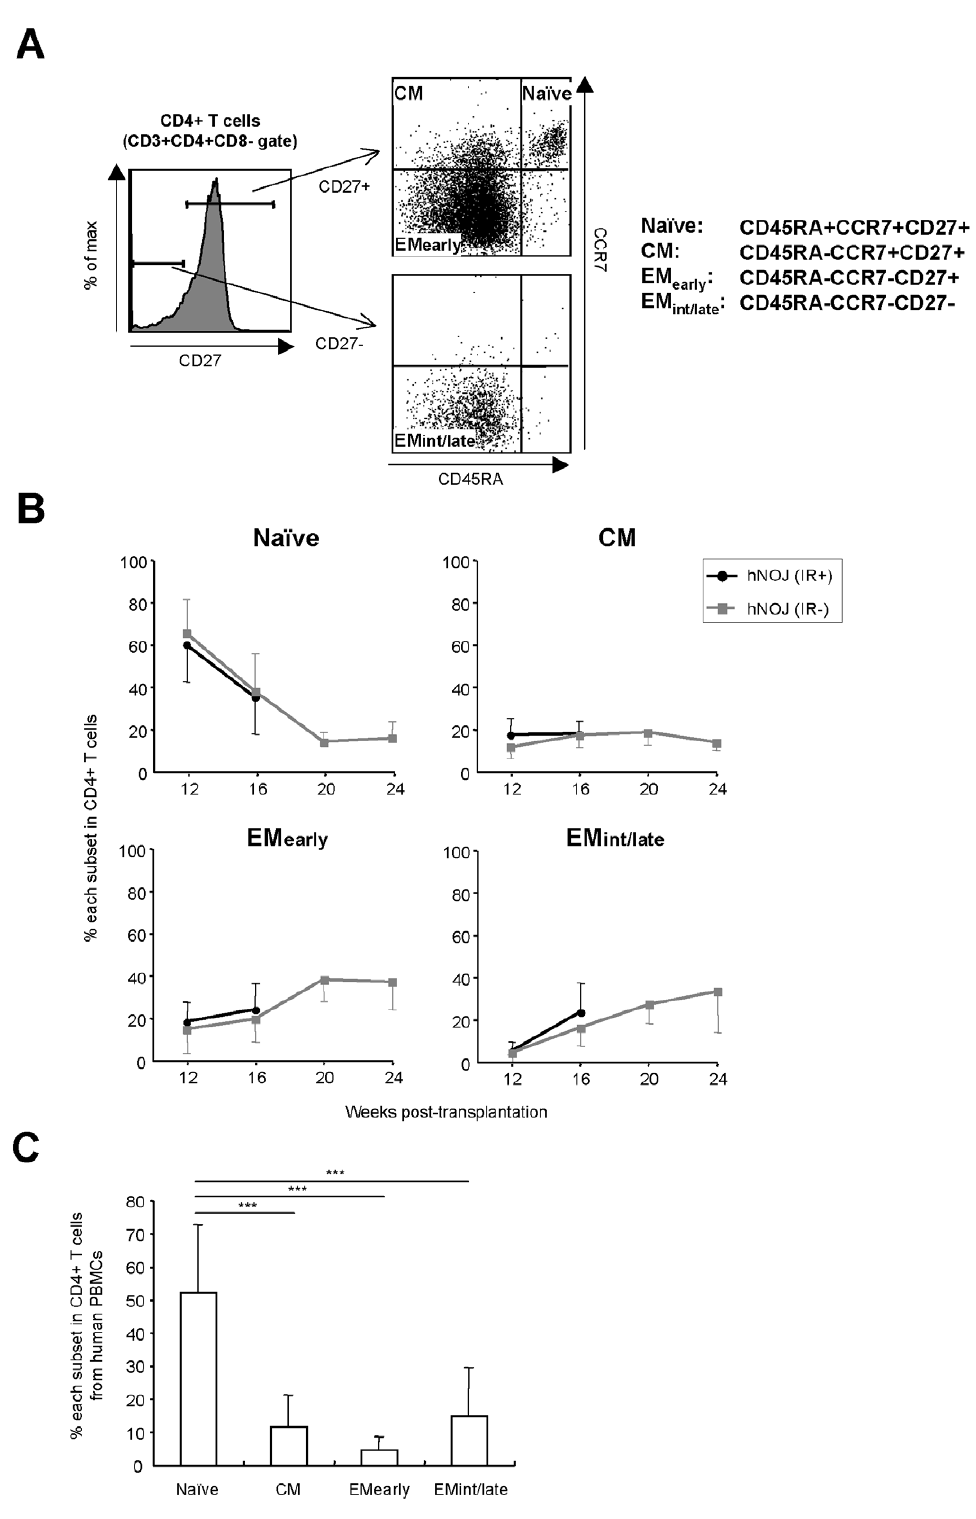
Figure 3. Differentiation of CD4 + T Cells in hNOJ mice. (A) Naı¨ve, CM, EM early , and EM int/late subsets of CD4 + T cells (gated on CD3 + CD4 + CD8 2 ) were defined as CD45RA + CCR7 + CD27 + , CD45RA 2 CCR7 + CD27 + , CD45RA 2 CCR7 2 CD27 + , and CD45RA 2 CCR7 2 CD27 2 , respectively, by flow cytometry. (B) Changes in the percentage of naı¨ve, CM, EM early , and EM int/late subsets within the peripheral blood CD4 + T cell populations isolated from hNOJ (IR + ) and hNOJ (IR 2 ) mice ( n =18 and n =6, respectively). Data are expressed as the mean 6 SD. (C) Percentage of CM, EM early , and EM int/late subsets within human peripheral blood CD4 + T cells. Data are expressed as the mean 6 SD ( n =10). Significant differences ( *** P , 0.001) were determined by Tukey’s multiple comparison test.